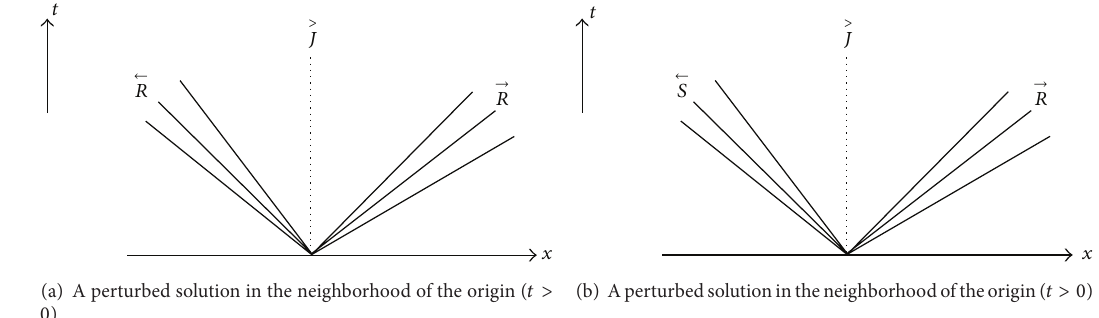
Figure 9: Solutions in Case